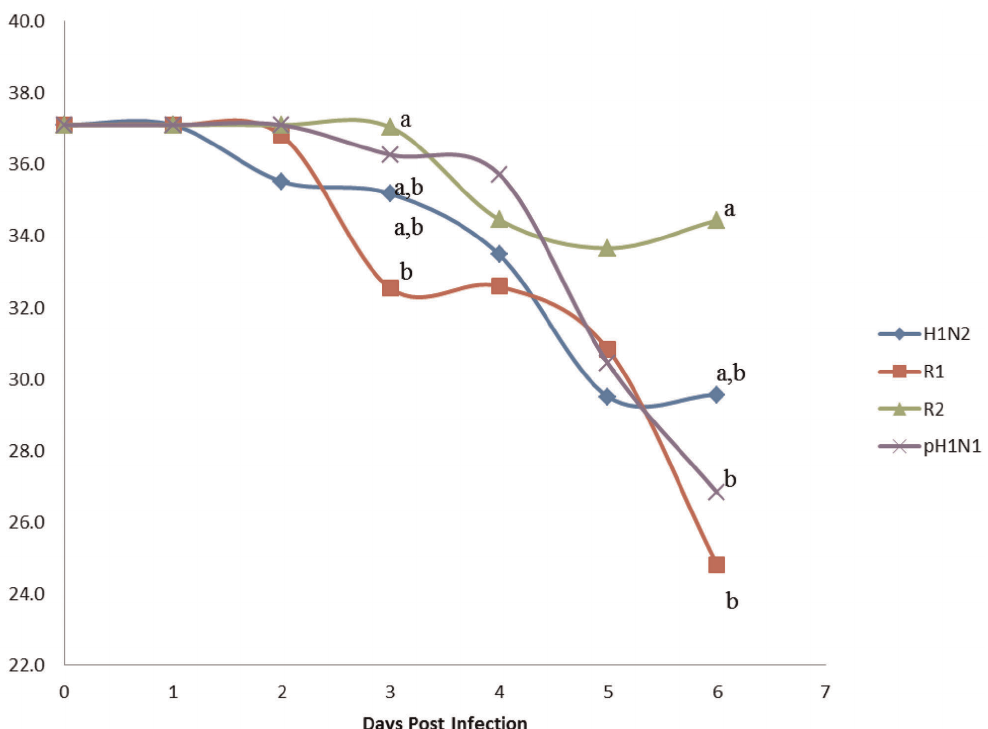
Figure 5. Four pigs were added to each of four rooms containing pigs challenged intranasally with 2 mL of 6.2 log10 TCID50/mL with H1N2, pH1N1, R1 or R2 at day one post infection. Nasal swabs were collected daily and analyzed by rt-RT-PCR for virus shedding. Data represent the mean Ct value for the four nasal swabs collected at each time point. Samples with different subscripts at a time point are statistically different (P , 0.05).